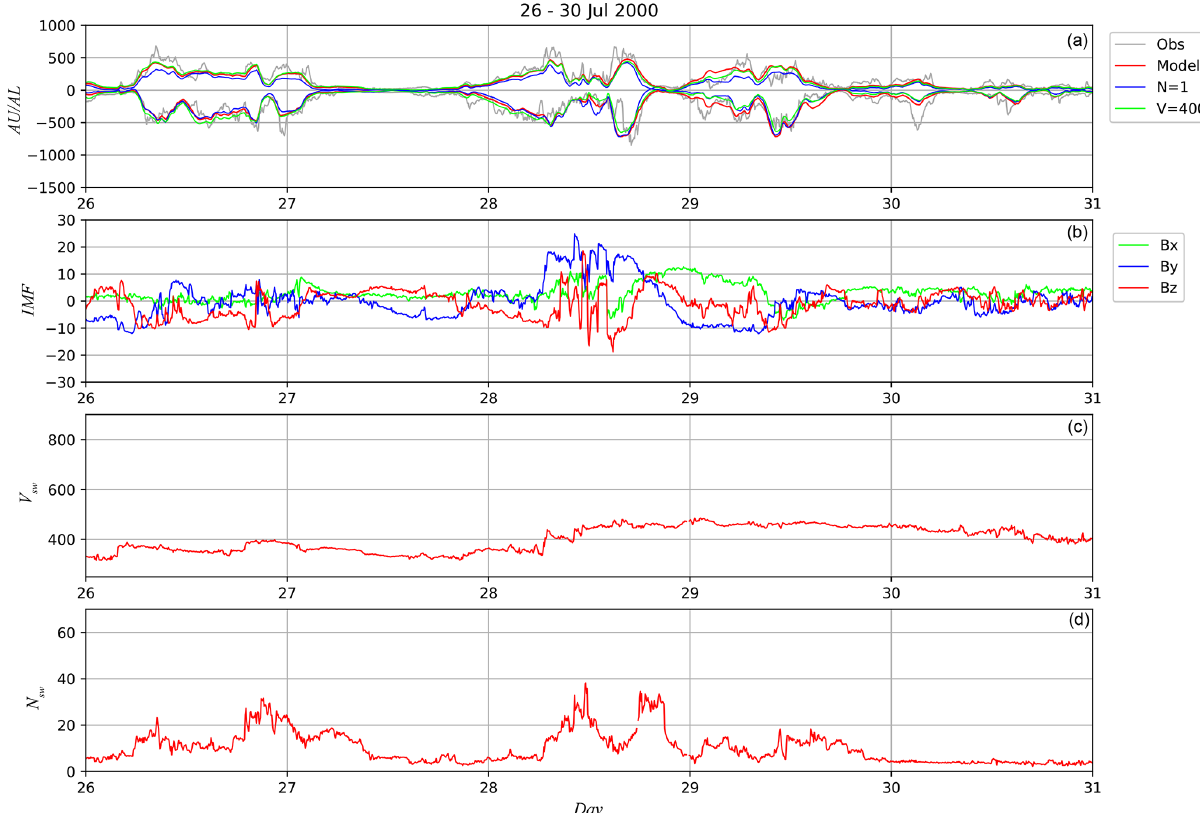
Figure 9. Comparison of ESN outputs during the period from 26 July to 30 July 2000 in the same format as Fig.